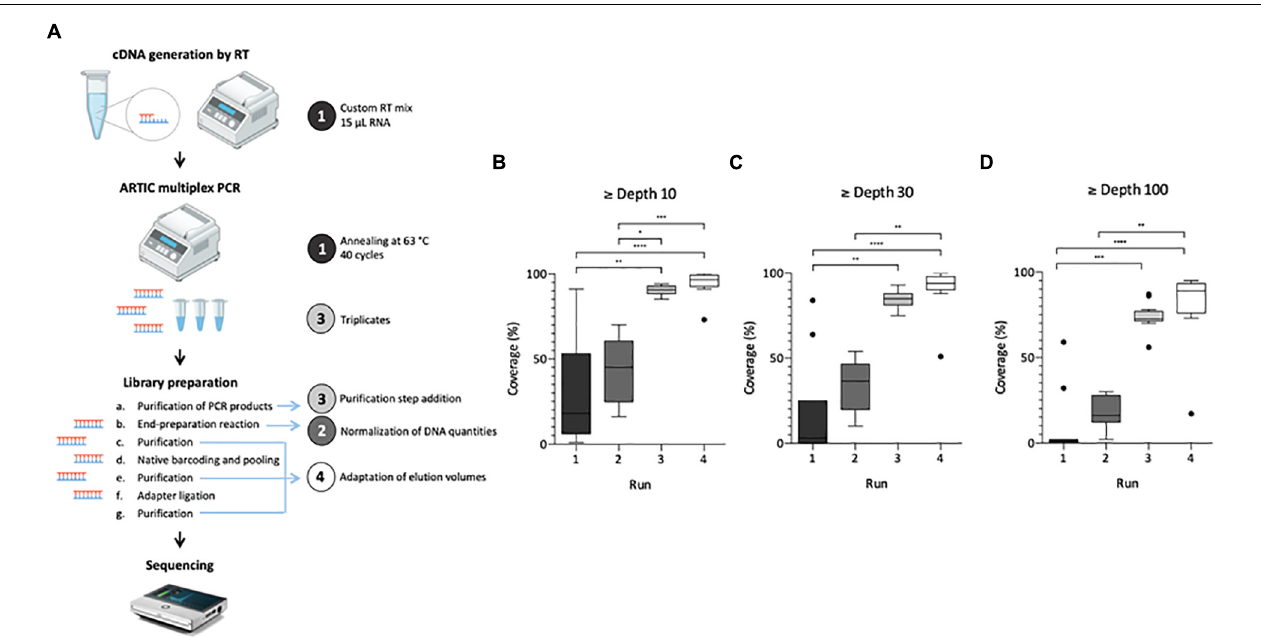
FIGURE 1 | Adaptation process of SARS-CoV-2 genome sequencing from wastewater samples. Left panel illustrates the protocol summary (A) with adaptation lines 1–4 depicted by a colored circle, same colors are used for box plot panels (B–D) . Box Plot (Tukey whiskers) of SARS-CoV-2 genome coverage percentages obtained per run of sequencing on raw wastewater samples at depth 10 (B) , 30 (C) , and 100 (D) during the adaptation process of the ARTIC protocol. Adaptation lines were for Run 1: cDNA synthesis (15 µ 1 RNA extract, random hexamers and SuperScript II reverse transcriptase), ARTIC multiplex PCR (annealing at 63 ◦ C, 40 cycles); Run 2: library preparation (normalization of initial DNA quantities); Run 3: ARTIC multiplex PCR (triplicates for each pool), library preparation (addition of an initial purification step of PCR products); Run 4: library preparation (addition of a purification step between the end-preparation and the barcoding reactions, adaptation of elution volumes to maximize recovery). Kruskal-Wallis test followed by Dunn’s multiple comparisons test were used to compare groups ( ∗∗∗∗ p < 0.0001, ∗∗∗ p < 0.001, ∗∗ p < 0.01, ∗ p < 0.05 and not significant if no indication on the plot) Panel A is adapted from Hourdel et al.